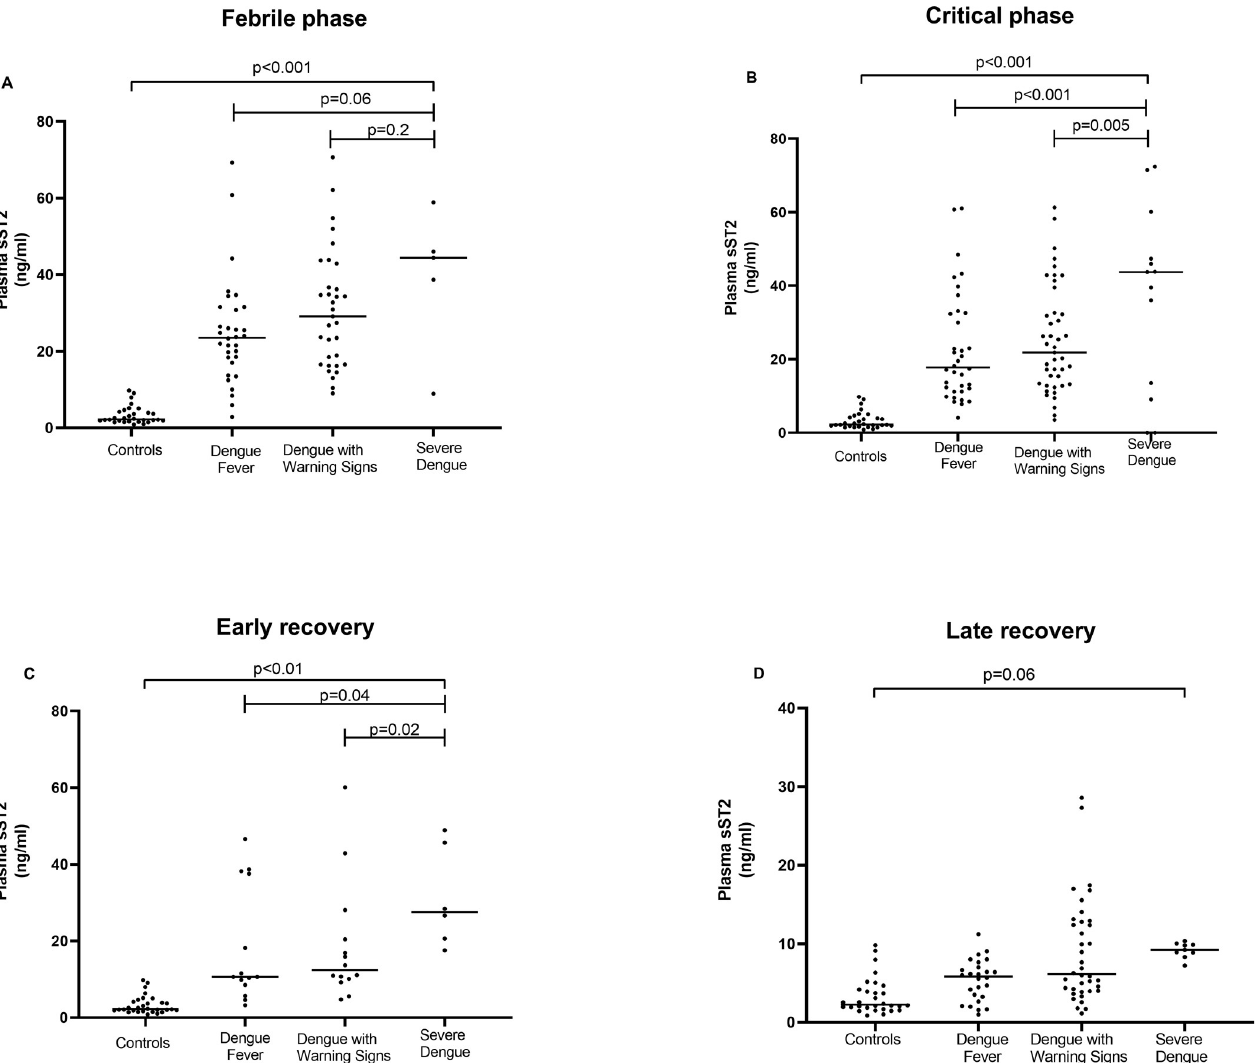
Fig 1. Plasma levels of sST2 in dengue subjects categorised by disease severities over time. Dengue subjects (n = 90) classified based on WHO 2009 dengue classifications–dengue fever (n = 36), dengue with warning signs (n = 43) and severe dengue (n = 11); controls (n = 30) collected at one time point were included in the analysis of plasma sST2 levels at: ( A ) early phase; ( B ) critical phase; ( C ) early recovery phase; and ( D ) late recovery phase. Plasma sST2 concentrations were determined by serial dilution of a standard curve. Data are presented as median (horizontal line). P values by Kruskal Wallis tests. Abbreviation: sST2, soluble suppression of tumorigenicity